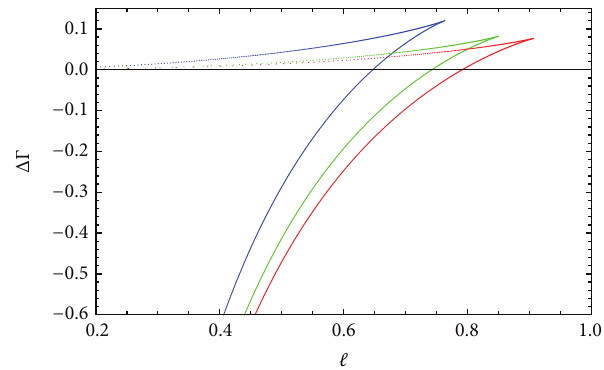
Figure 2: ΔΓ as a function of ℓ for the cases of 𝑄 = 0, 0.3, 0.5 which are shown by red, green, and blue, respectively. The blue curve corresponds to the case where 𝑟 𝐻 = 𝑟 𝜙 , and the red one corresponds to the neutral case. Here, we have set 𝑟 𝐻 = 1 and 𝜏𝐿 𝑑−2 𝑅 𝑑 /𝐺 𝑑+2 = 1